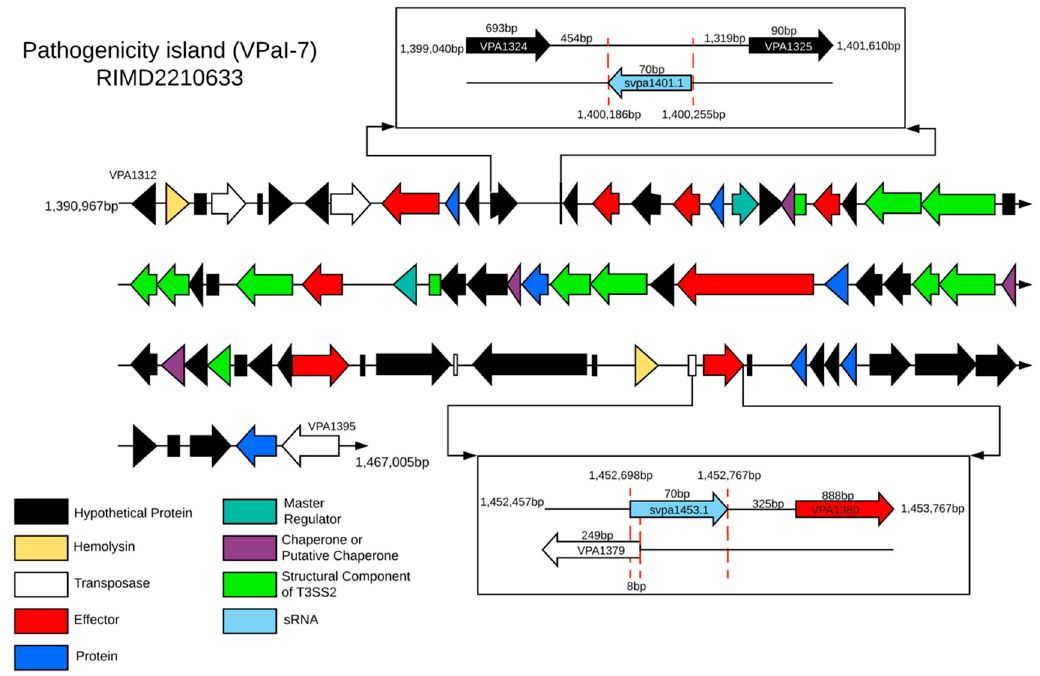
Figure 3. Identification of the target gene regulated by svpa1401.1 and svpa1453.1, and their genomic context visualized in the genome of reference strain RIMD2210633. VPaI-7 defined by Makino and collaborators [28], and Xu and collaborators [29].